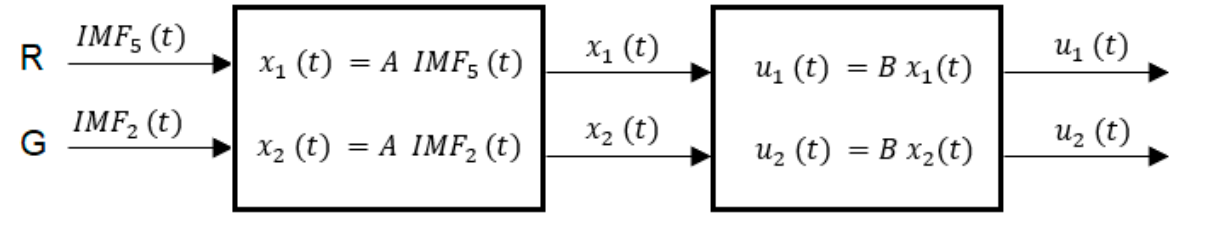
Figure 8. Basic schematic diagram of the ICA technique.